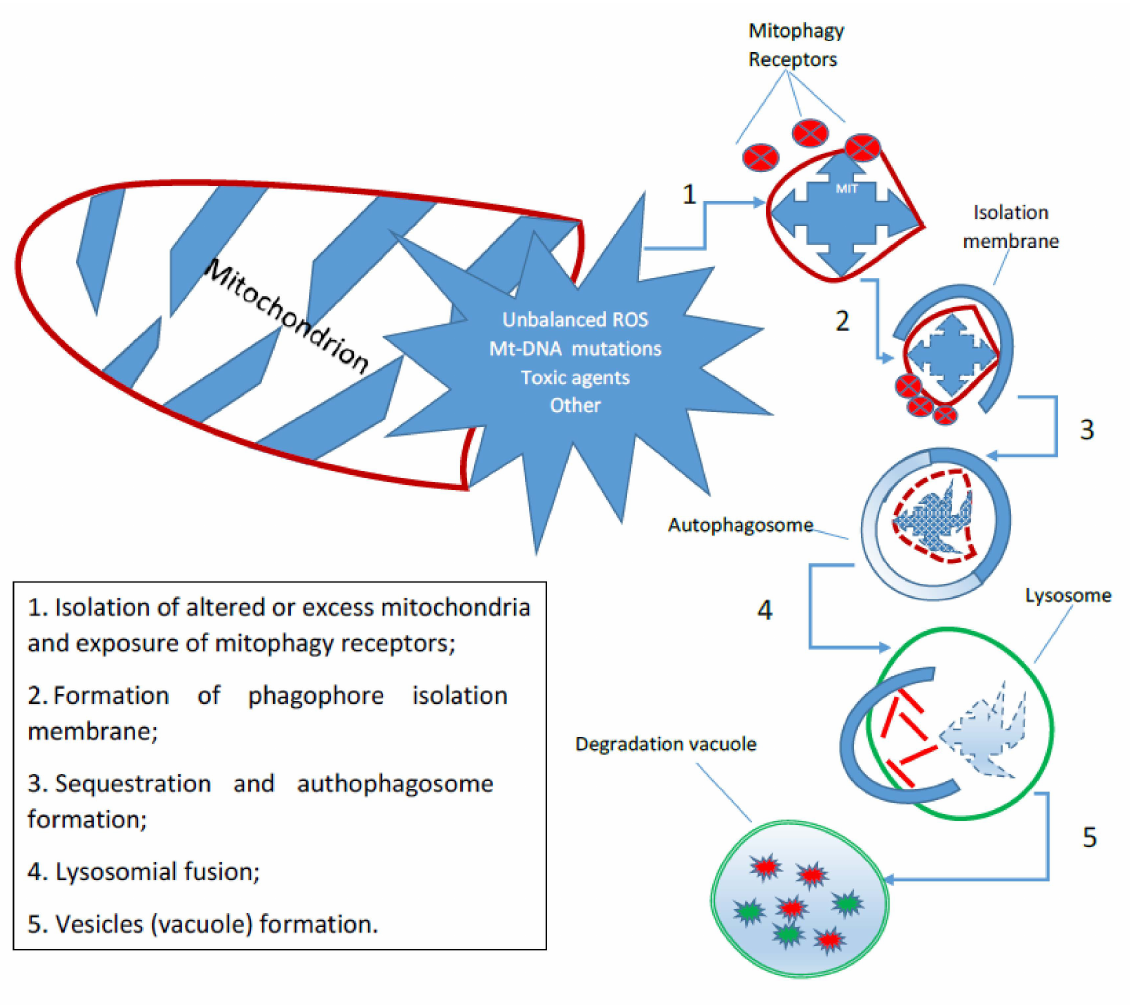
Figure 2. Scheme of Mitophagy. Mitophagy is a phylogenetically conserved mechanism that regulates the control of mitochondrial quality and quantity. It is triggered by specific receptors on the outer mitochondrial membrane or by ubiquitin molecules conjugated to proteins on the mitochondrial surface that lead to the formation first of autophagosomes and then degradation